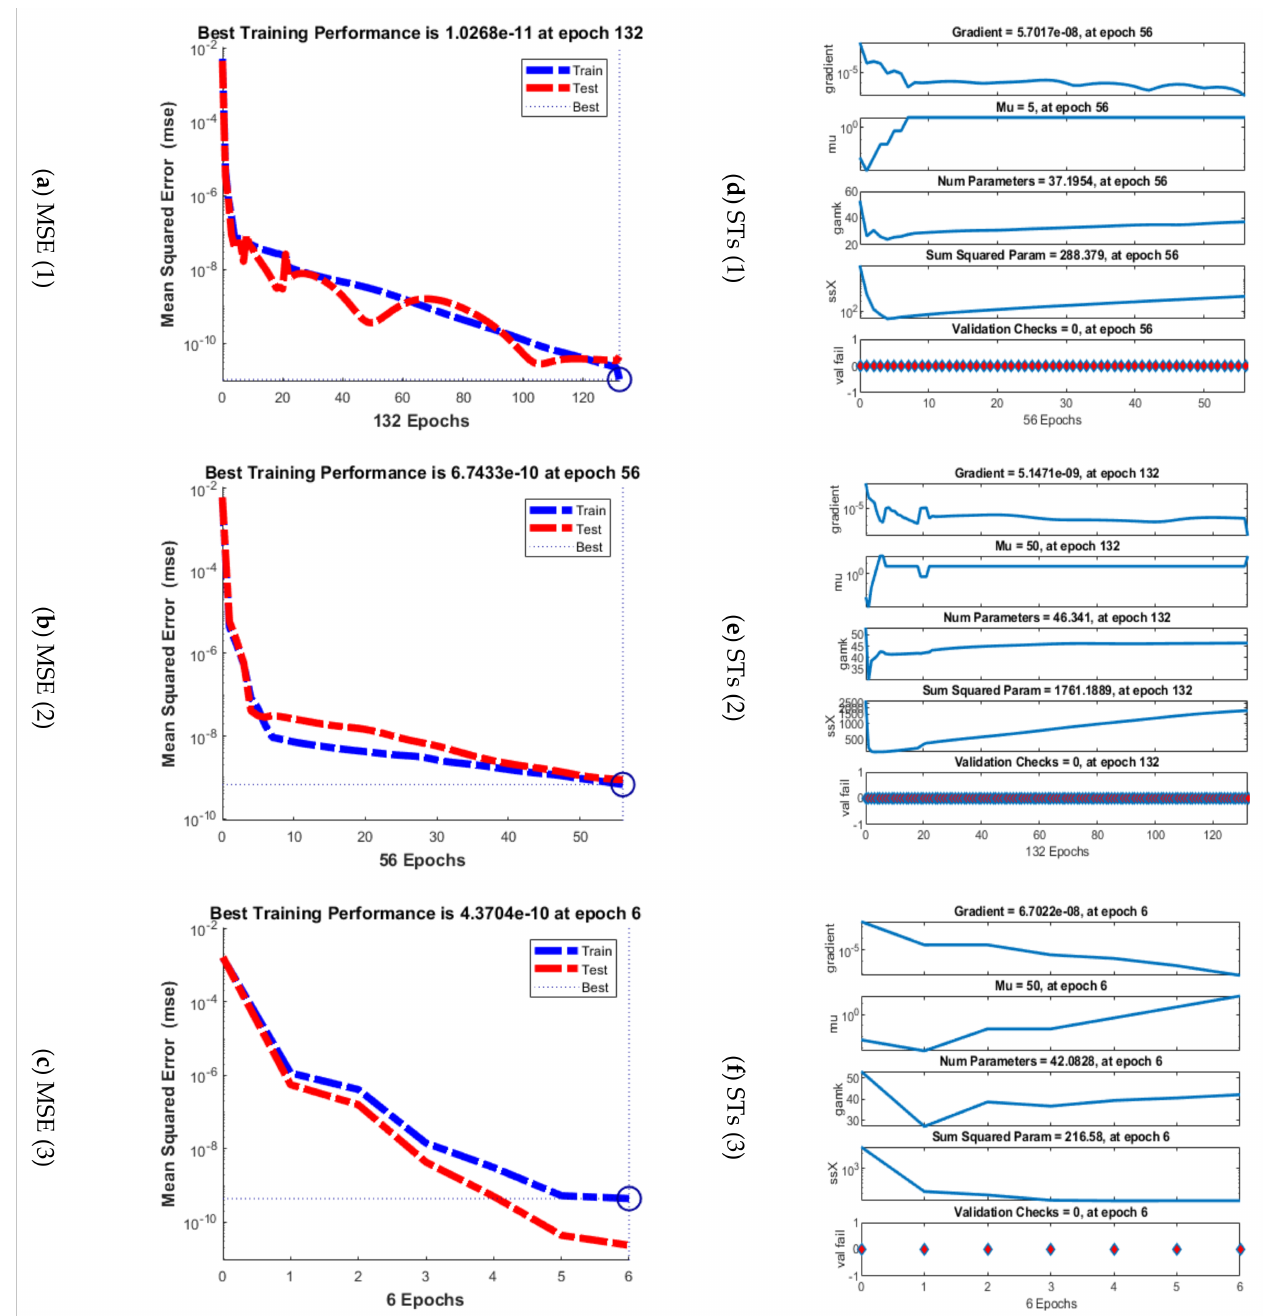
Figure 3. The performances of MSE and STs to solve the dynamical